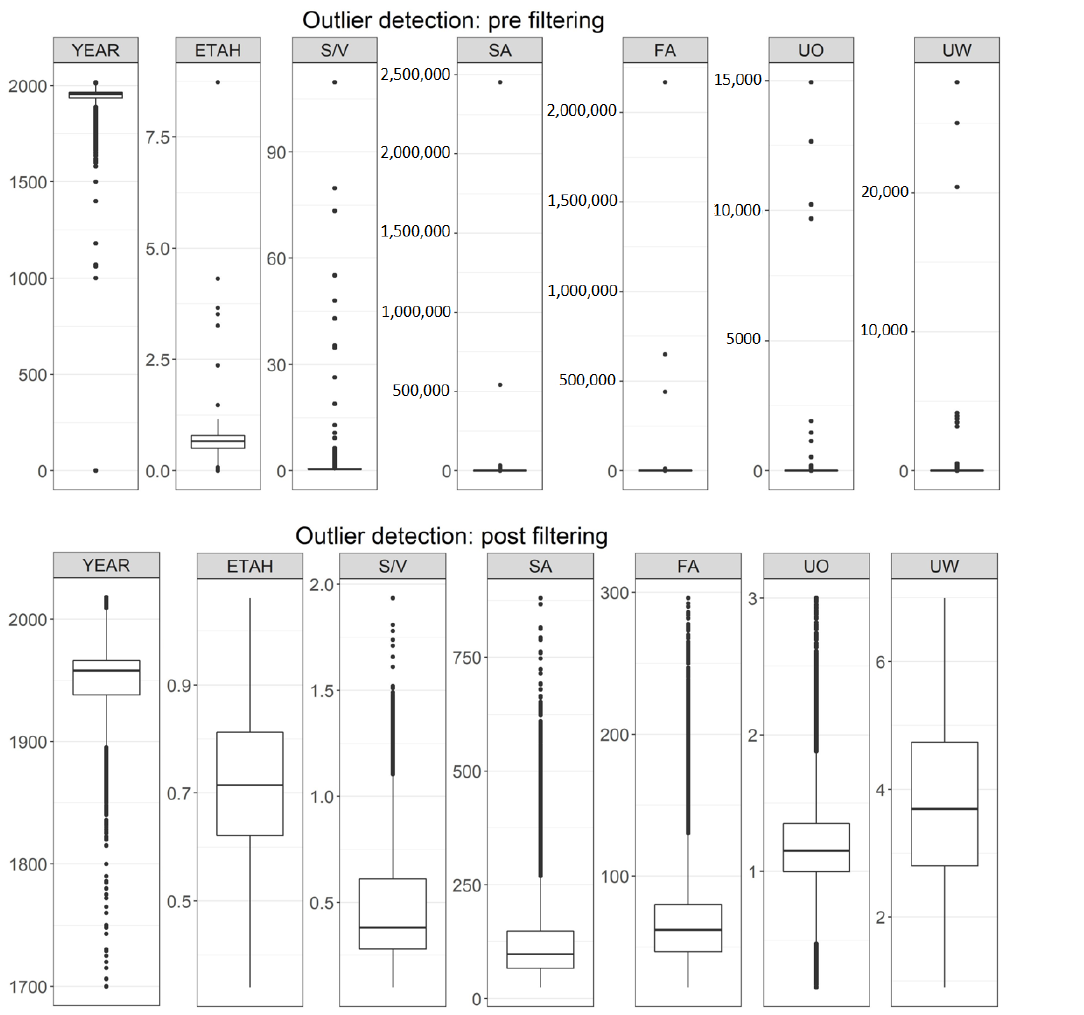
Figure 7. Effect of the pre-processing phase before and after the outlier detection and removal through the boxplot representation.